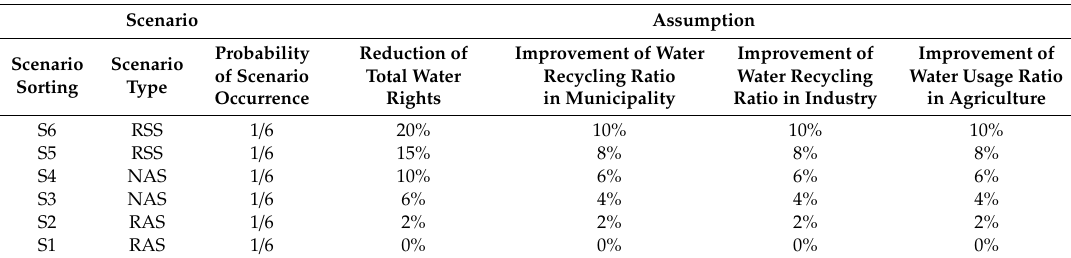
Table 1. Scenario design.